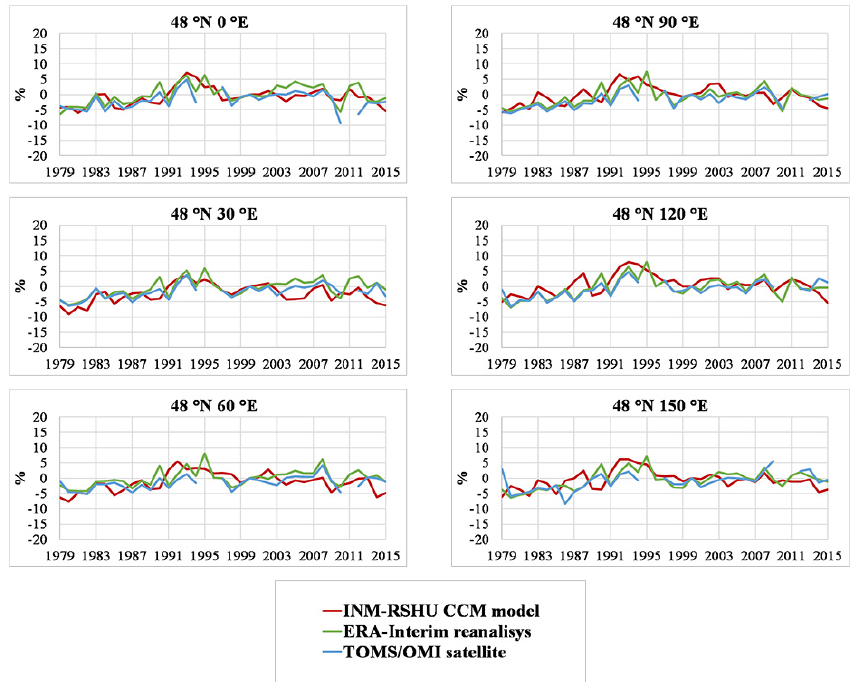
Figure 8. The time series of the Eery relative anomalies against 2000 at 48° N from 0° E to 150° E according to the INM-RSHU CCM, ERA-Interim, and TOMS/OMI satellite datasets.